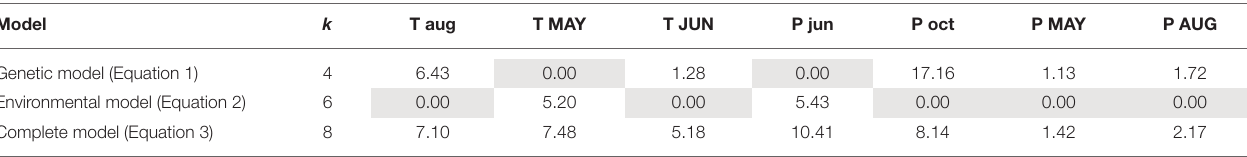
TABLE 3 | Results of the model selection explaining variability in growth-climate correlation coefficients among sites for each of the main climatic variables (columns from Figure 2). Model k T aug T MAY T JUN P jun P oct